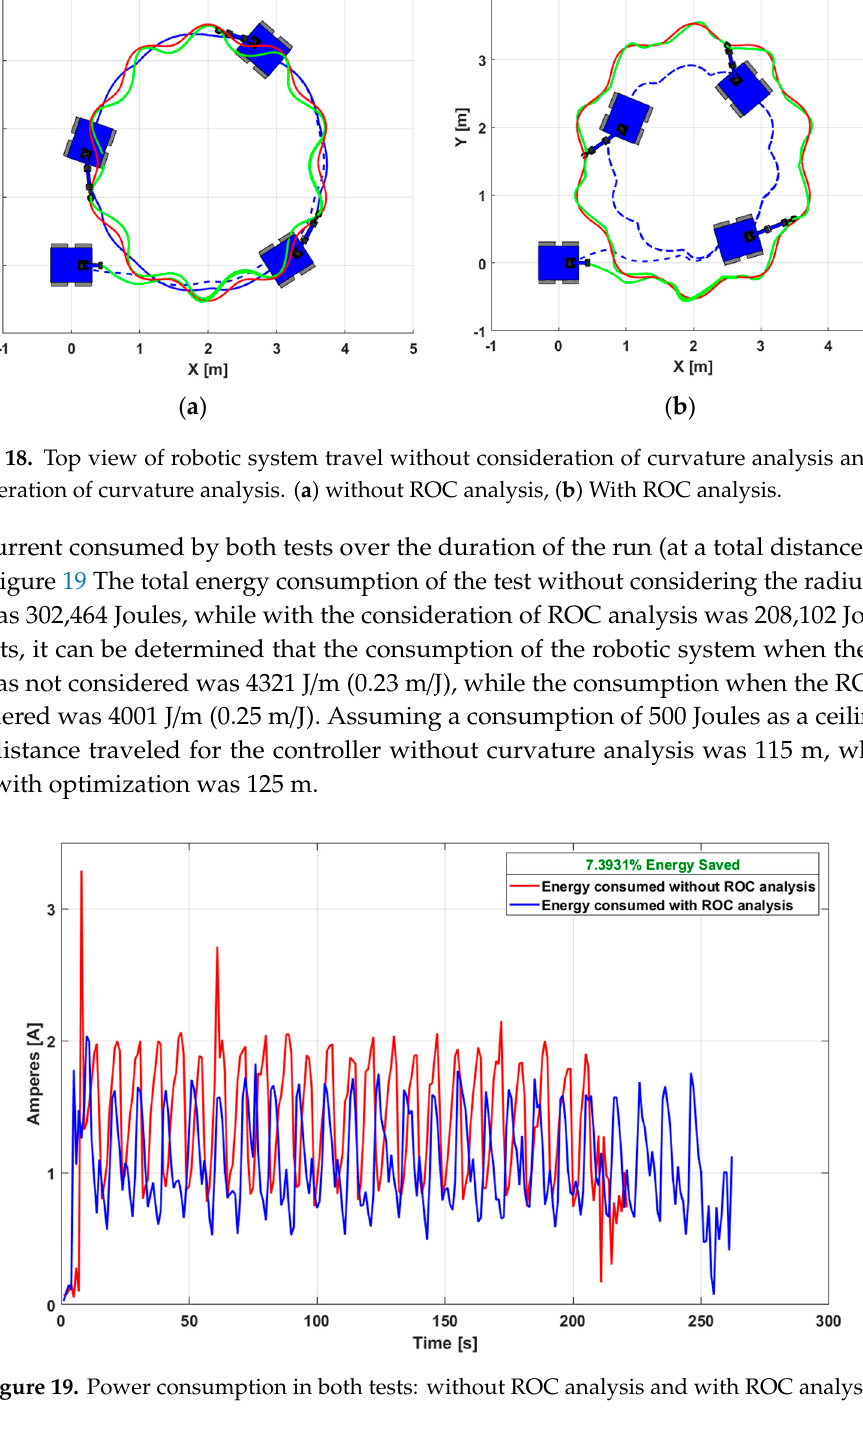
Figure 19. Power consumption in both tests: without ROC analysis and with ROC analysis.